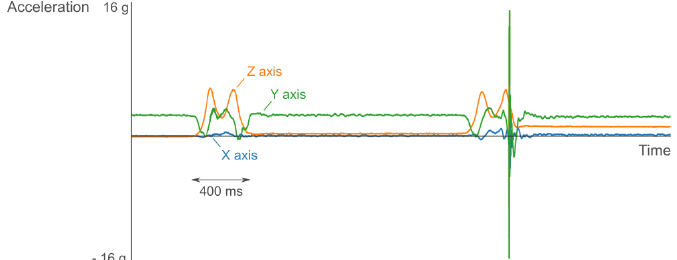
Figure 6. Impact shuttle when placing the sensor on the racket’s grip. The blue, green and orange line represent the respectively X, Y, and Z axis of the accelerometer. Left: stroke when not hitting the shuttle. Right: same stroke when the shuttle is hit. This shows a peak in the Y axis of the accelerometer when hitting the